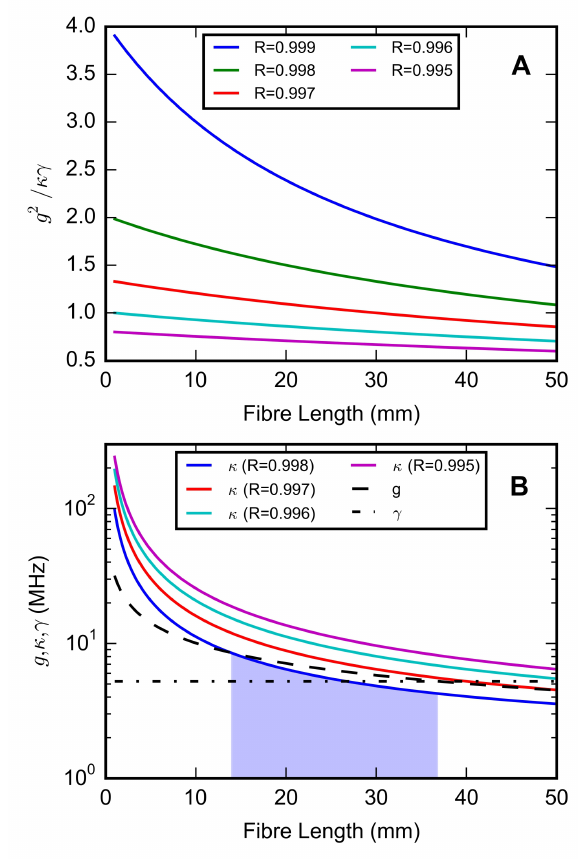
Fig. 12. (A) Shows g 2 / κγ vs. fiber length. High cooperativity regime occurs when g 2 > κγ . (B) Shows g , κ and γ vs. fiber length. Strong coupling regime occurs when atom-cavity coupling exceeds the cavity decay rate ( κ ) and the lifetime of the excited state ( γ ), g > κγ , as shown by the shaded region. Calculations were done for the cesium transition at a wavelength of 852 nm, and a fundamental Gaussian fiber mode radius of 2.75 µm 2